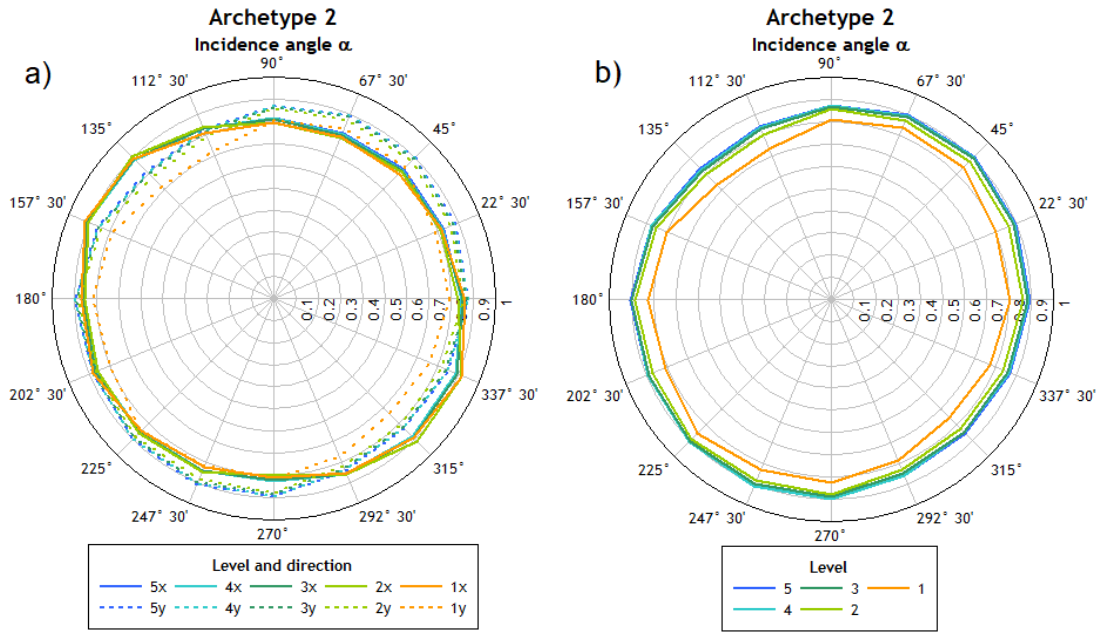
Figure 12. Mean interstory drift normalized for Archetype 2 per story, ( a ) without and ( b ) with SRSS combination.